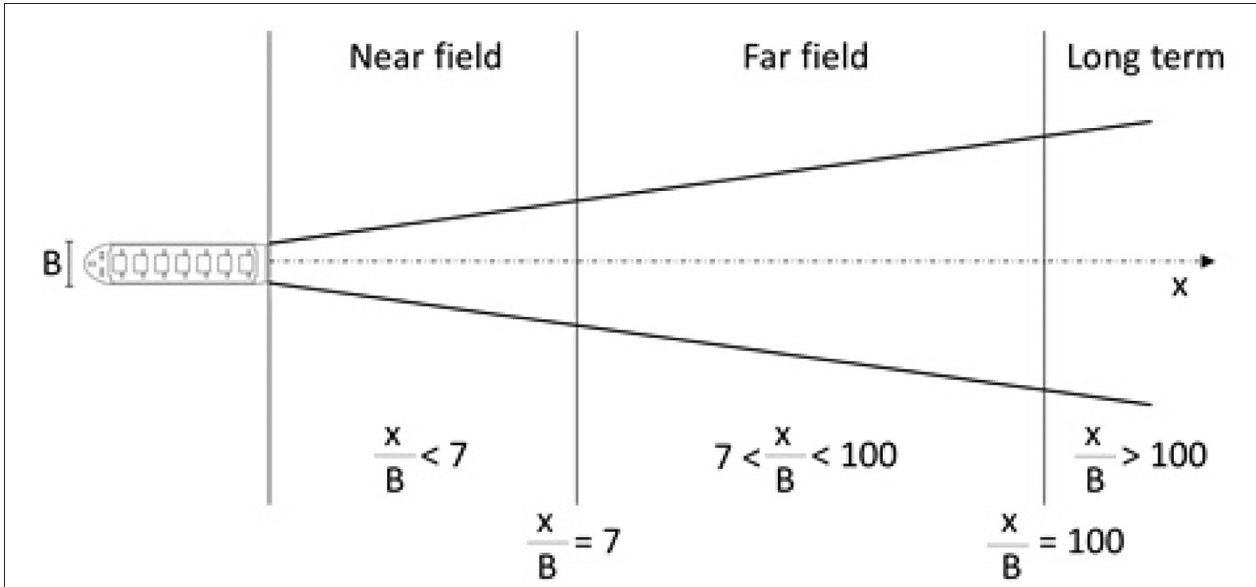
FIGURE 3 | Schematic subdivision of the ships’ wake (adapted from Chou,